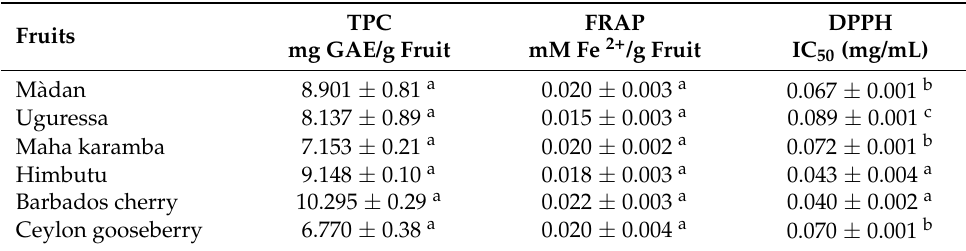
Table 3. Total phenolic content and antioxidant